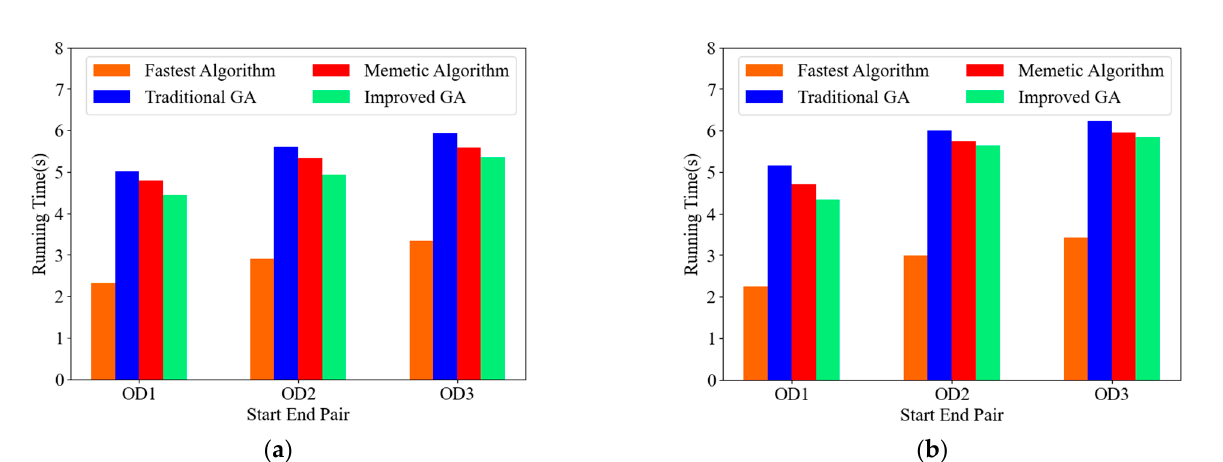
Figure 8. Comparison of scenic score under different start end pairs. ( a ) Xi’an; ( b ) Wuhan.